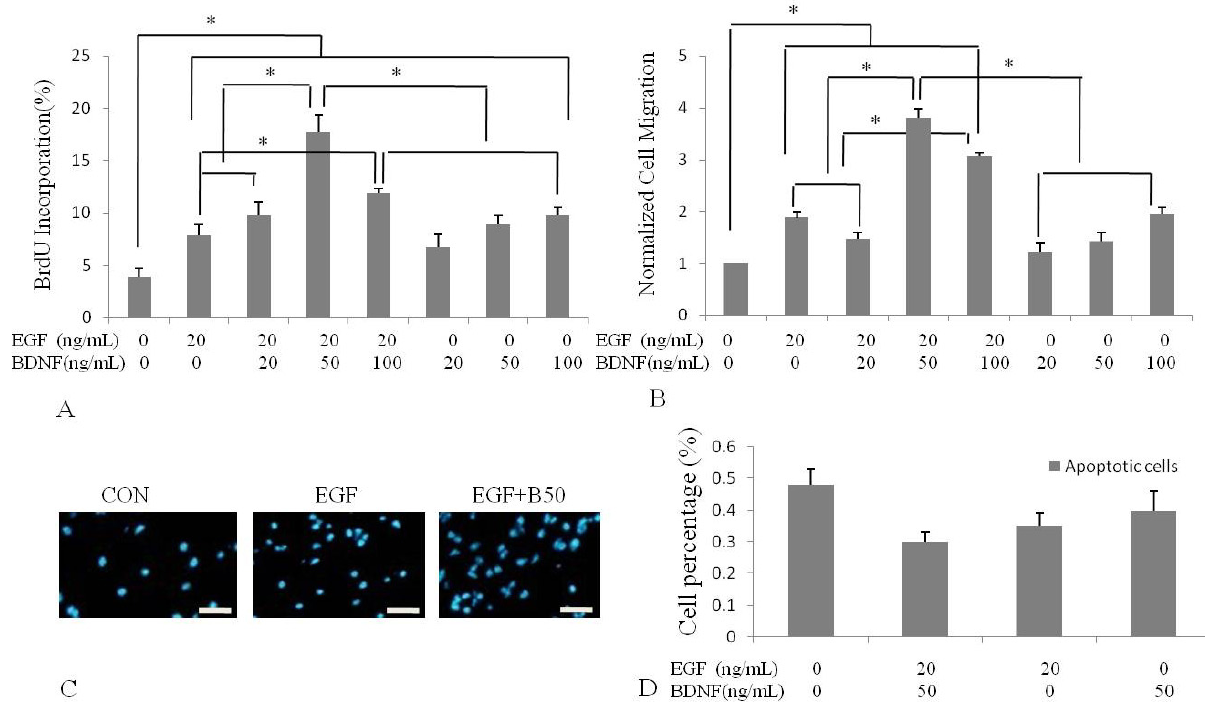
Figure 1. Effect of BDNF on EGF-induced human NSPC proliferation and migration. Quantitative analysis of human NSPCs proliferation ( A ) and migration ( B ) were determined by BrdU incorporation and Transwell assay following 2 hours treatment of different concentrations of BDNF stimulation with 20 ng/mL EGF or not. (B) Data were expressed as mean ratio compared with the control group; ( C ) Cells incubated with EGF or EGF and BDNF. Nuclei were counter-stained with DAPI; ( D ) Analysis of apoptosis by Flow-cytometry. There was no appreciable change in these groups CON: control (incubated with medium without EGF or BDNF). * p < 0.05, Scale bar = 20 μ